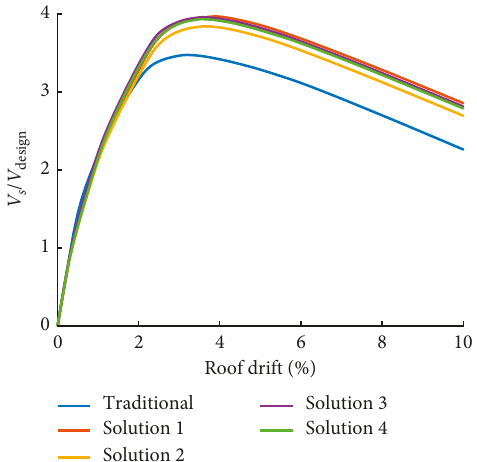
Figure 5: Pushover results for the eight-story